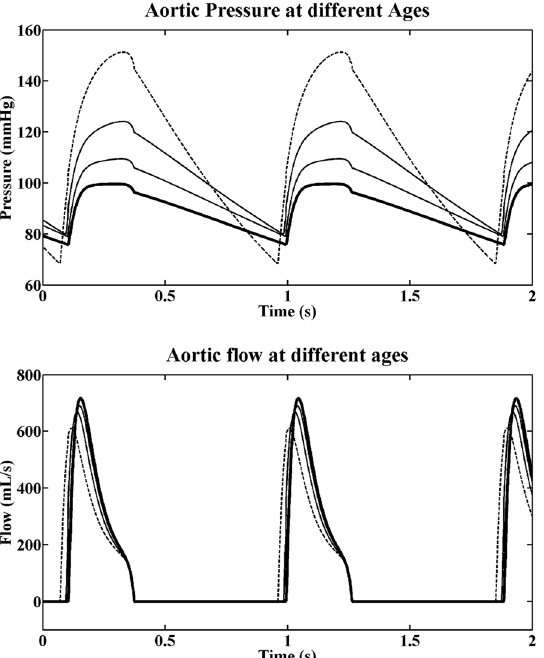
Fig 3. Aortic pressure and flow profiles. The curves were computed at 20 (bold), 40, 60 and 80 (dashed) years of ages, when considering both the contribution of the arterial and cardiac changes.